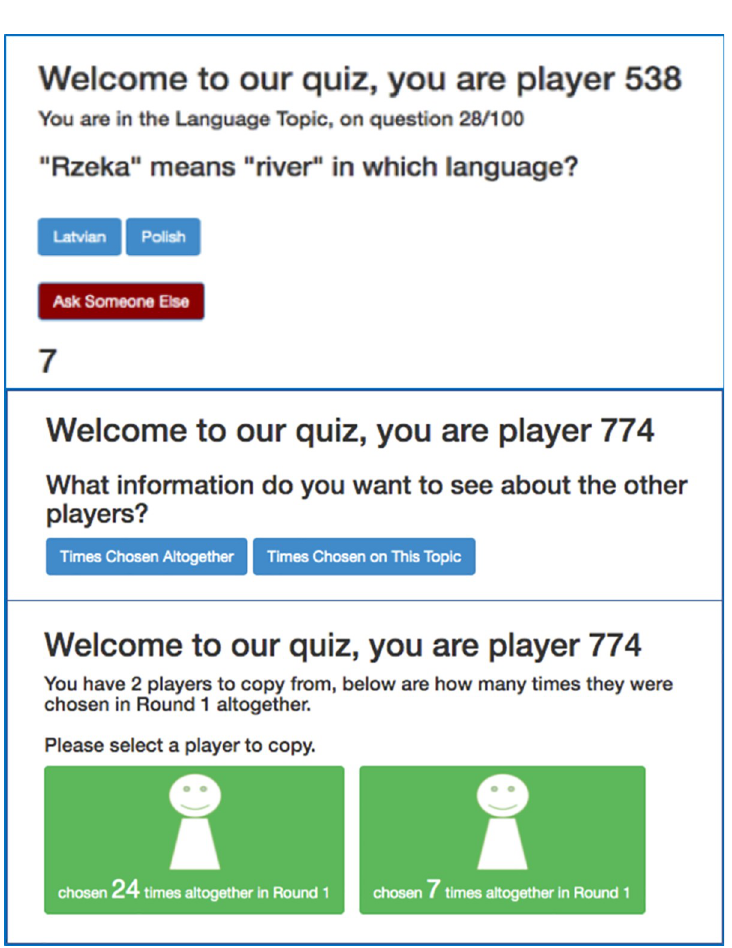
Fig 1. Three example screenshots representing what participants saw at different stages of the experiment. The top screenshot is an example question from the language topic. Participants could either select one of the two blue buttons showing two possible answers (one correct, one incorrect), or select the red button labelled “Ask Someone Else” which allows participants to copy someone else within their group. The number ‘7’ at the bottom is a countdown timer that forces participants to answer within 15 seconds. The second image represents what a participant would see if they chose to “Ask Someone Else” in Round 2 of Condition C, where they could choose to either view Times Chosen Altogether (domain-general prestige) or Times Chosen On This Topic (domain-specific prestige). The bottom image represents what a participant would see if they chose ‘Times Chosen Altogether’ and (domain-general prestige), in which there were only two other players to choose from. Please note that for any given question, participants could have between one and nine other participants to choose from, depending on how many answered individually for that particular question. See Table 1 for the information combinations displayed in the other Conditions. See S1 File for screenshots for all